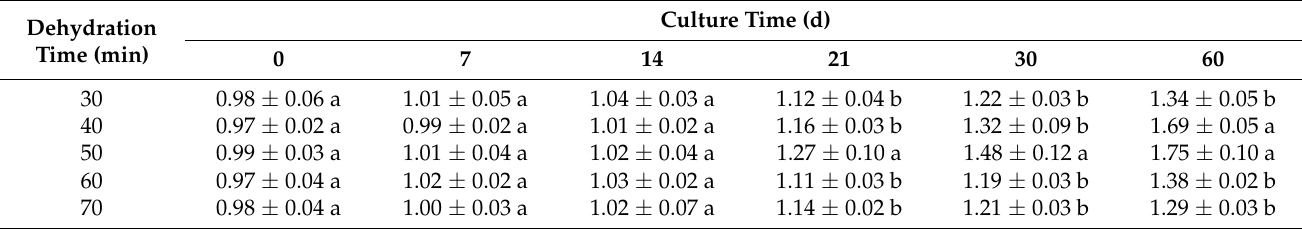
Table 4. Effect of dehydration time on fresh weight of F. mandshurica EC after cryopreservation by